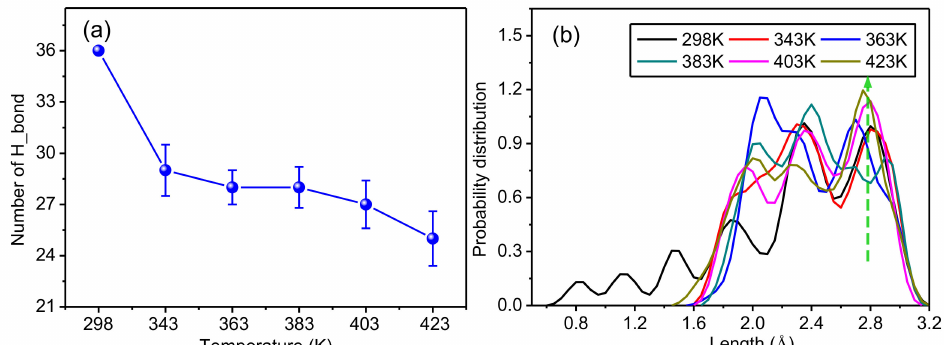
Figure 13. Influence of temperature on the hydrogen bonding network in amorphous regions of meta-aramid fibers. ( a ) Relation between temperature and hydrogen bond number and ( b ) probability distributions of hydrogen bond lengths at different